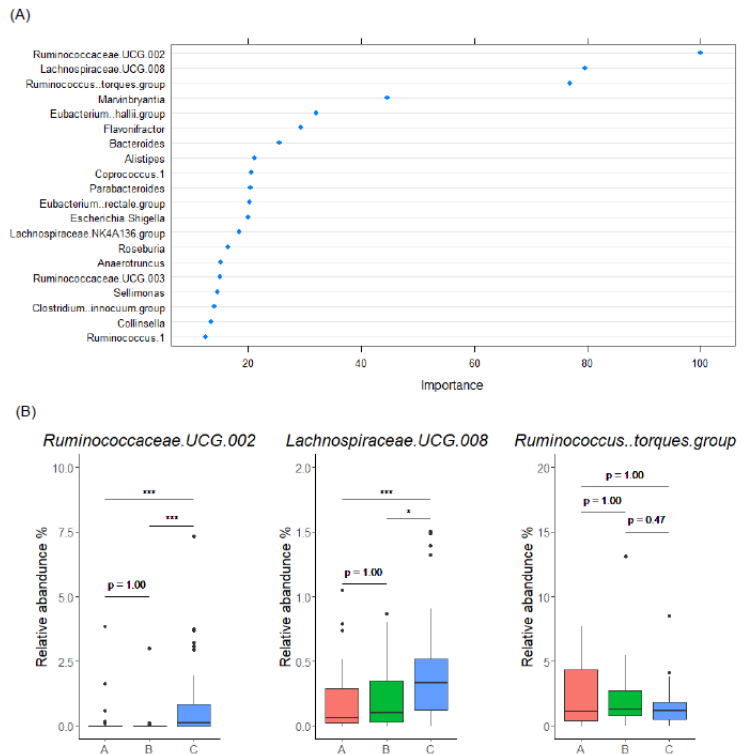
Figure 5. A random forest model to classify EL producers based on microbial genus data. ( A ) The top 20 explanatory variables that are important for EL producer classification (Model 1). ( B ) Relative abundance of the top 3 explanatory variable bacteria. In the box plots, the boundary of the box closest and farthest to zero indicates the 25th and 75th percentile, respectively, and a black line within the box marks the median. Whiskers indicate minimum and maximum values. Points above the whiskers indicate outliers. Statistical significance was evaluated by Kruskal − Wallis test followed by Bonferroni ’ s multiple comparison test. * p < 0.05, and *** p < 0.001.